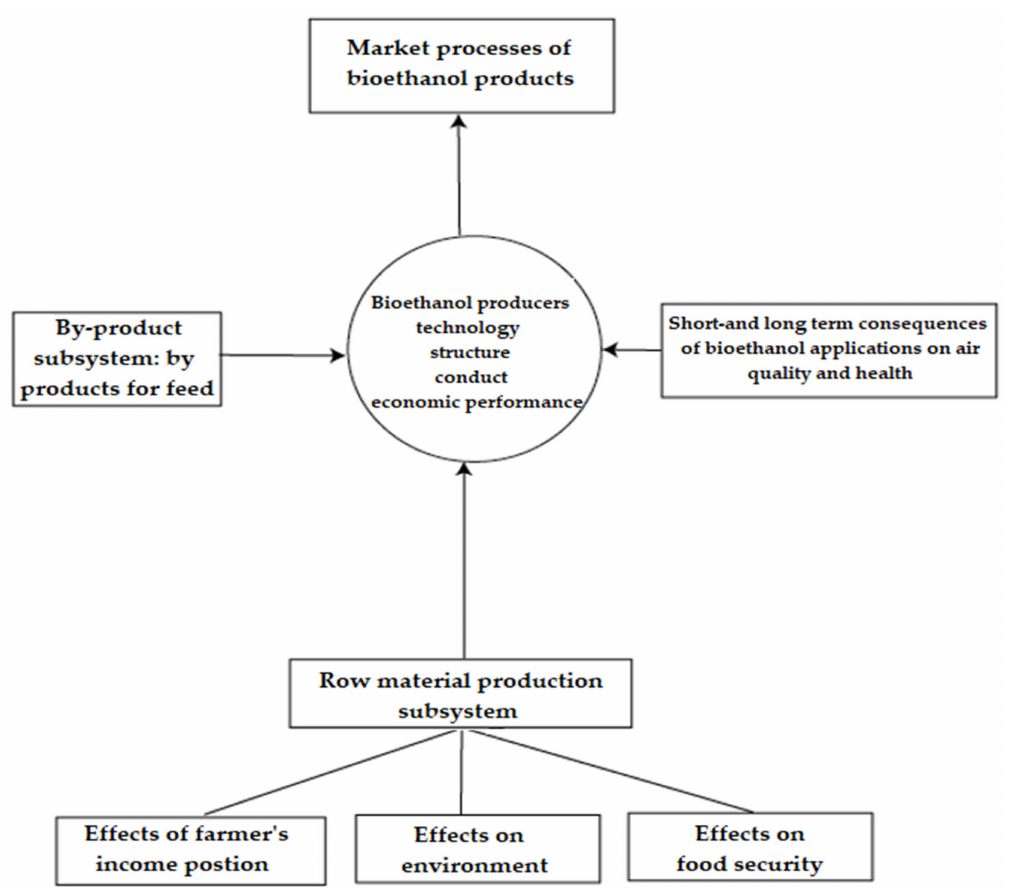
Figure 3. The basic building blocks of this model (source: own research,